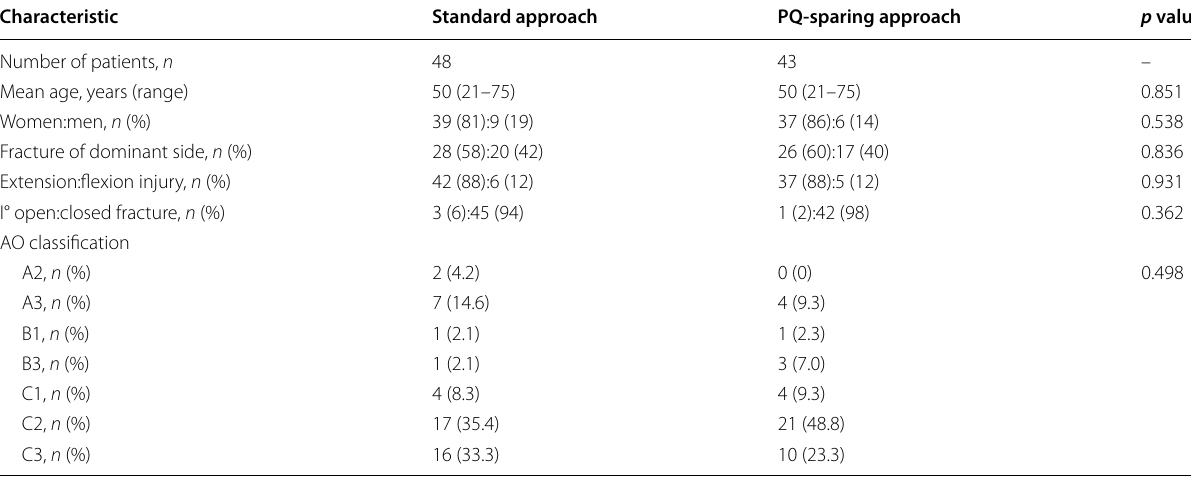
Table 1 Demographics of patients with distal radius fractures treated with either the standard volar approach or the